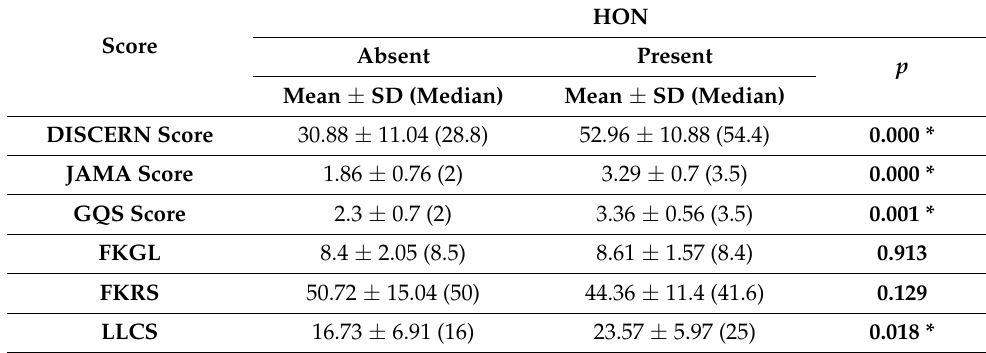
Table 4. Evaluation of scores according to the presence of HON